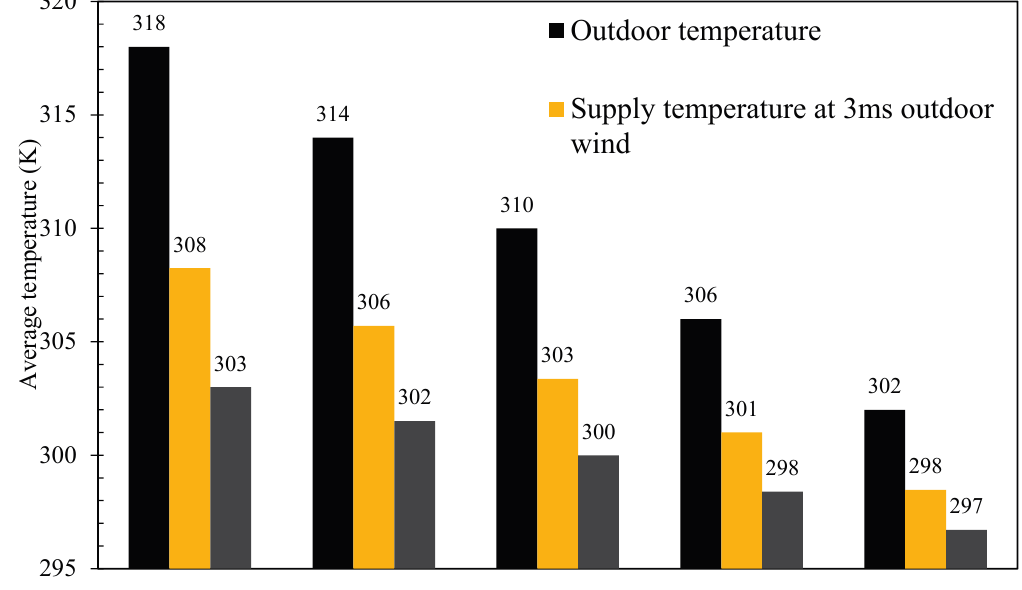
Figure 18. Effect of the outdoor temperature on the supply air temperature.